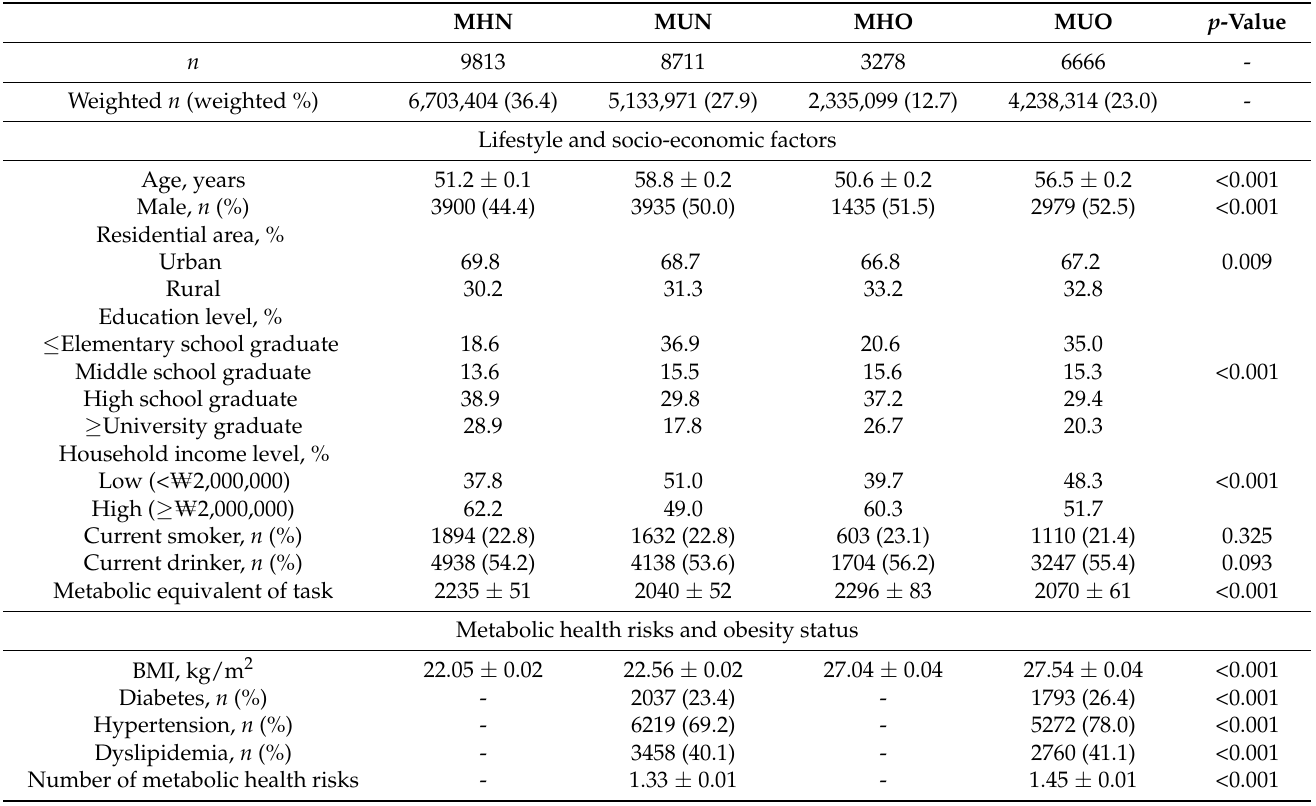
Table 1. Characteristics of study population according to the combination of metabolic health risk and obesity status in KNHANES. MHN MUN MHO MUO p